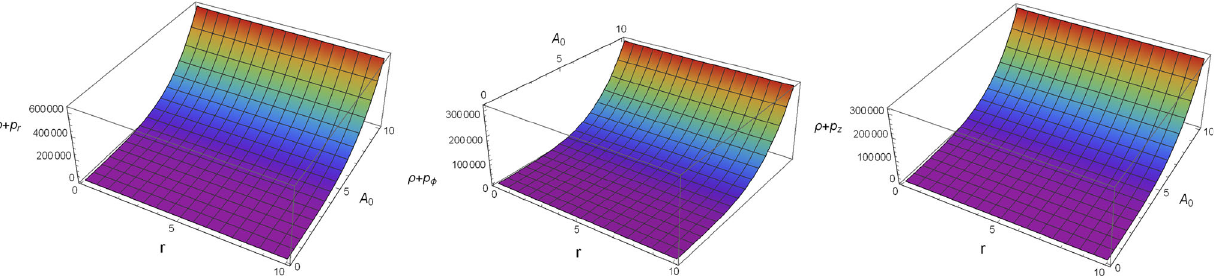
Fig. 22 The graphs shows the variation of (ρ + p r ) (MeV/fm 3 ) , (ρ + p φ ) (MeV/fm 3 ) and (ρ + p z ) (MeV/fm 3 ) w.r.t r (km) with m = n = 1. One can clearly sees the validity of NEC through this panel for r ≥ 0. CASE